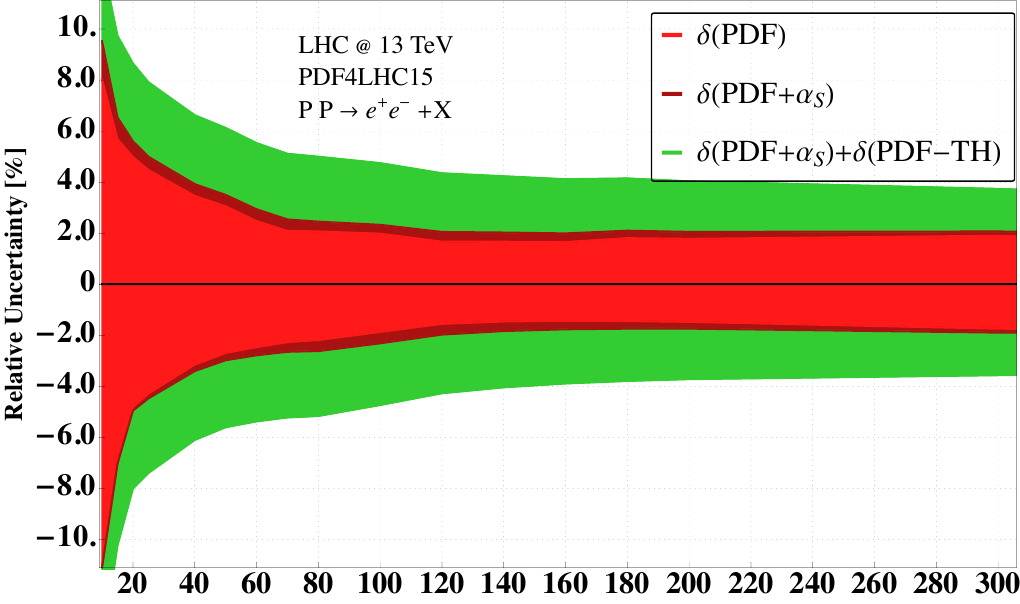
Figure 12. Relative uncertainty of the NCDY process at N 3 LO due to incomplete knowledge of parton distribution functions and the strong coupling constant as a function of Q . δ ( PDF ) , δ ( PDF + α s ) and the sum of δ ( PDF + α s ) and δ ( PDF-TH ) are shown in red, brown and green respectively.